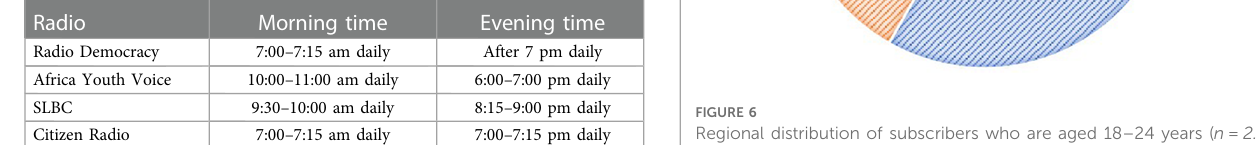
TABLE 3 Four radio stations for disseminating the WiTok recorded contents.